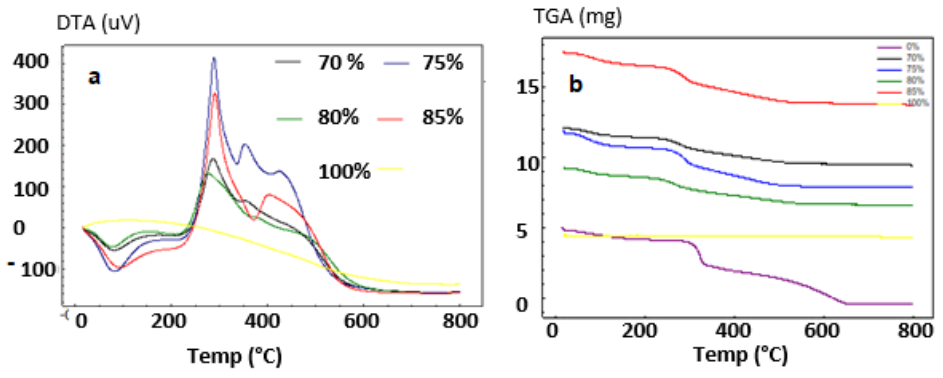
Figure 3. DTA ( a ) and TGA; ( b ) Spectrum of HAp/CTs